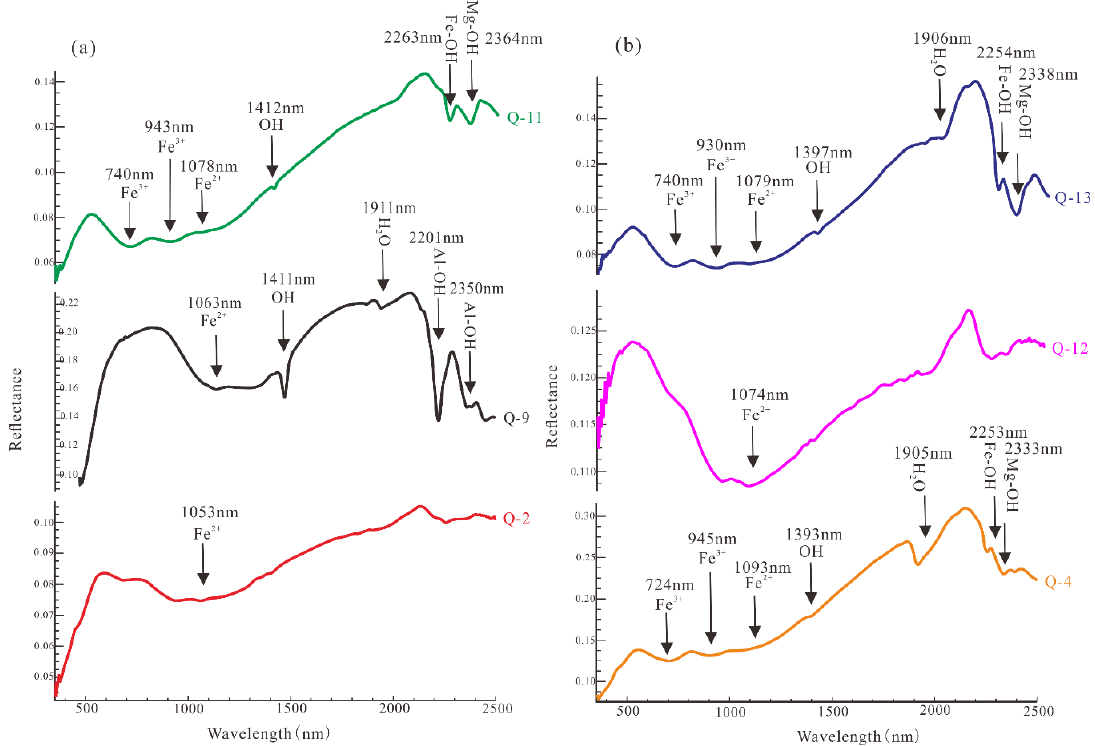
Figure 12. The point spectra of the samples: ( a ) samples near high-grade iron ore and ( b ) samples near banded iron formations (BIFs).